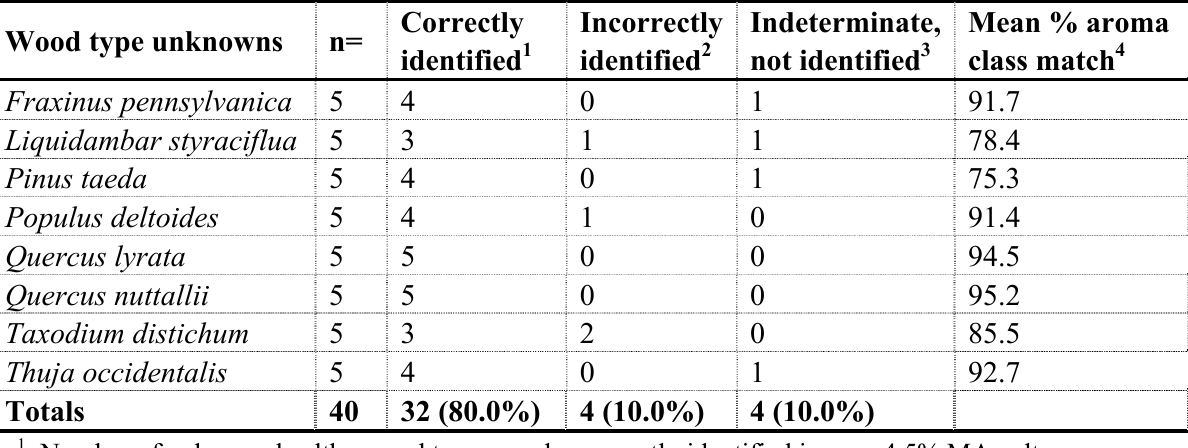
Table 5. Tests of the AromaScan A32S in the identifications of eight uninoculated